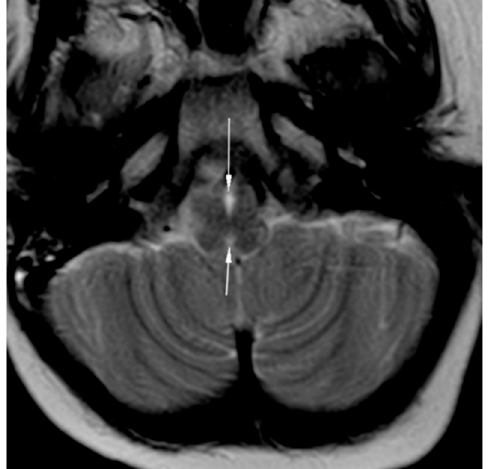
Figure 5. MRI brain axial T2-weighted image showing butterfly medulla oblongata.